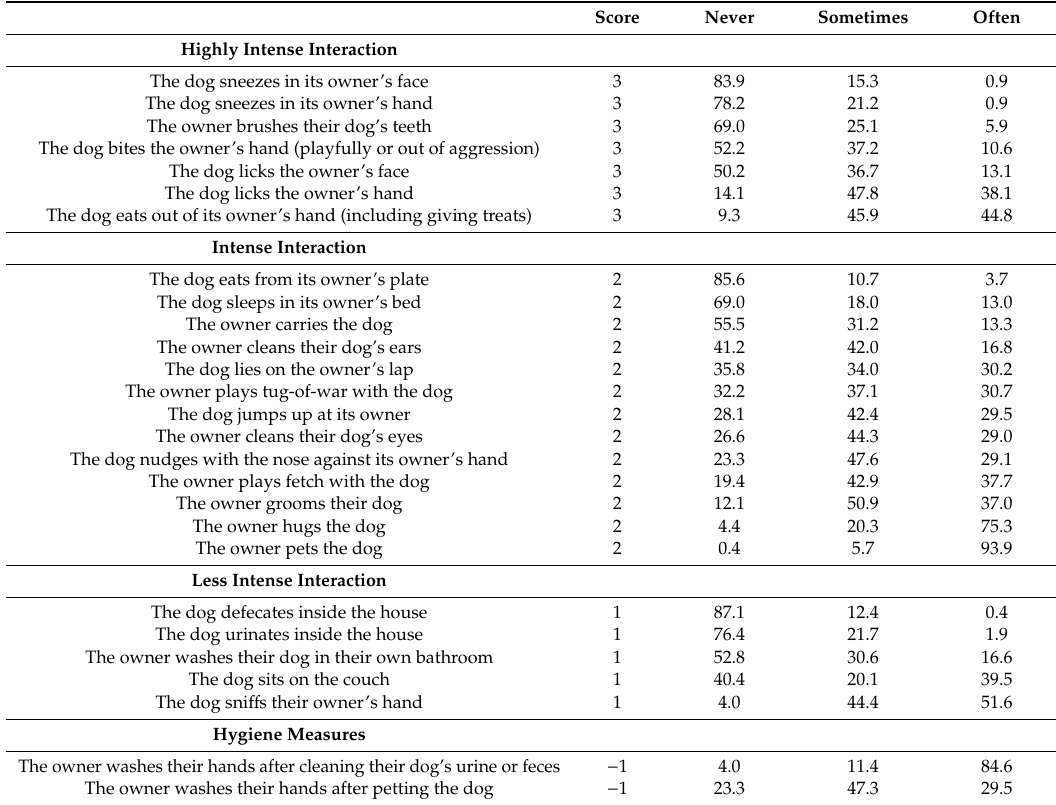
Table 1. The frequency and score of interactions between dogs and their owners. The interactions are categorized as highly intense, intense, and less intense interactions. Scores assigned to each category: 1 for less intense interactions, 2 for intense interactions, and 3 for highly intense interactions. Hygiene measures were assigned a negative score of − 1. The table is based on the observations of the 701 completed questionnaires that were considered in the